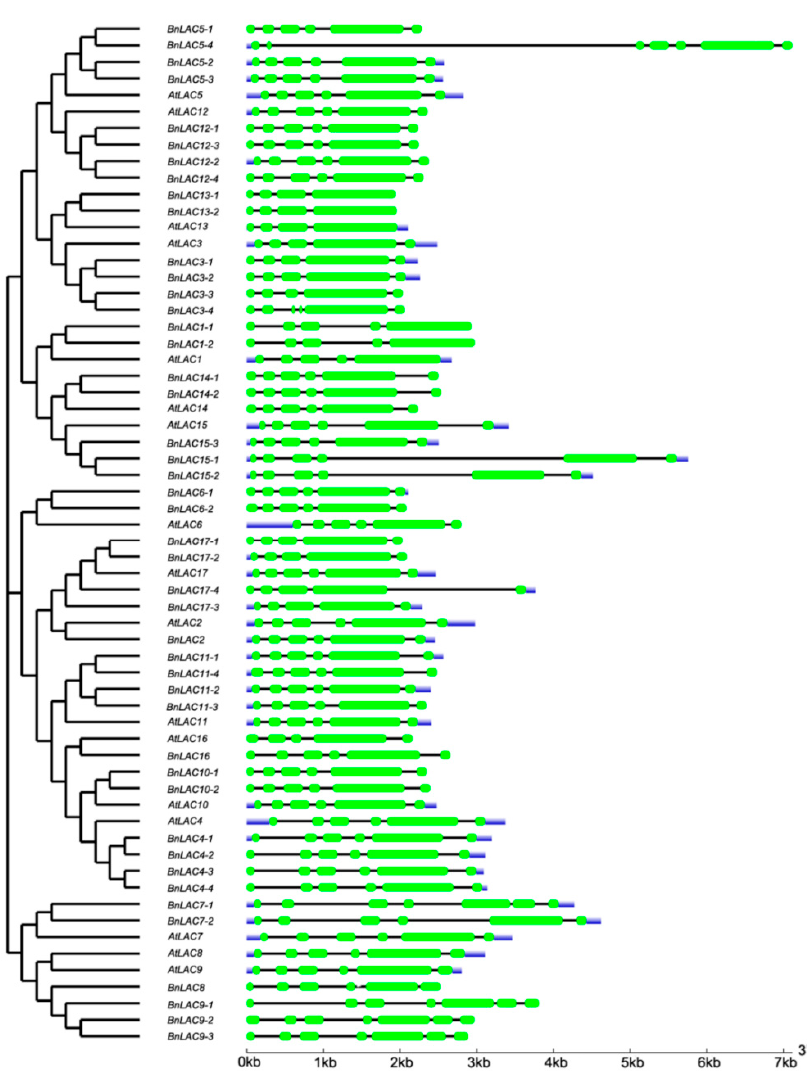
Figure 4. Exon-intron structures of BnLACs and AtLACs with a cladogram. The result generated by GSDS 2.0 (http://gsds.cbi.pku.edu.cn/). The green boxes, black lines and blue box indicate exons, introns, untranslated region,